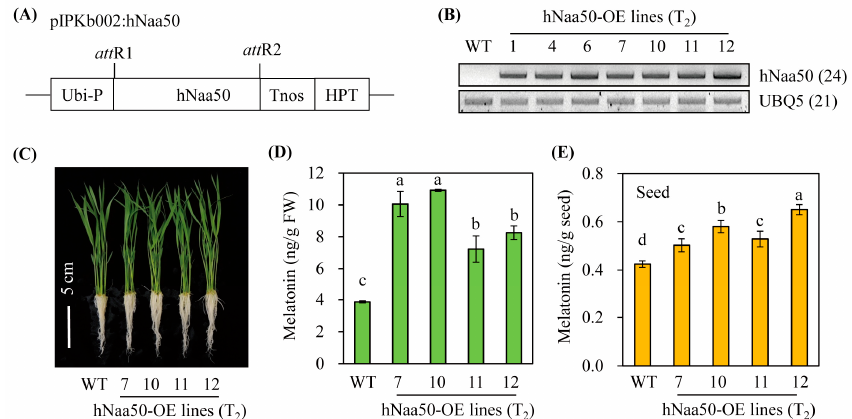
Figure 5. ( A ) Schematic diagram of a binary vector designed for hNaa50 overexpression. ( B ) Reverse transcription (RT)-polymerase chain reaction (PCR) analyses of transgenic and wild-type rice plants